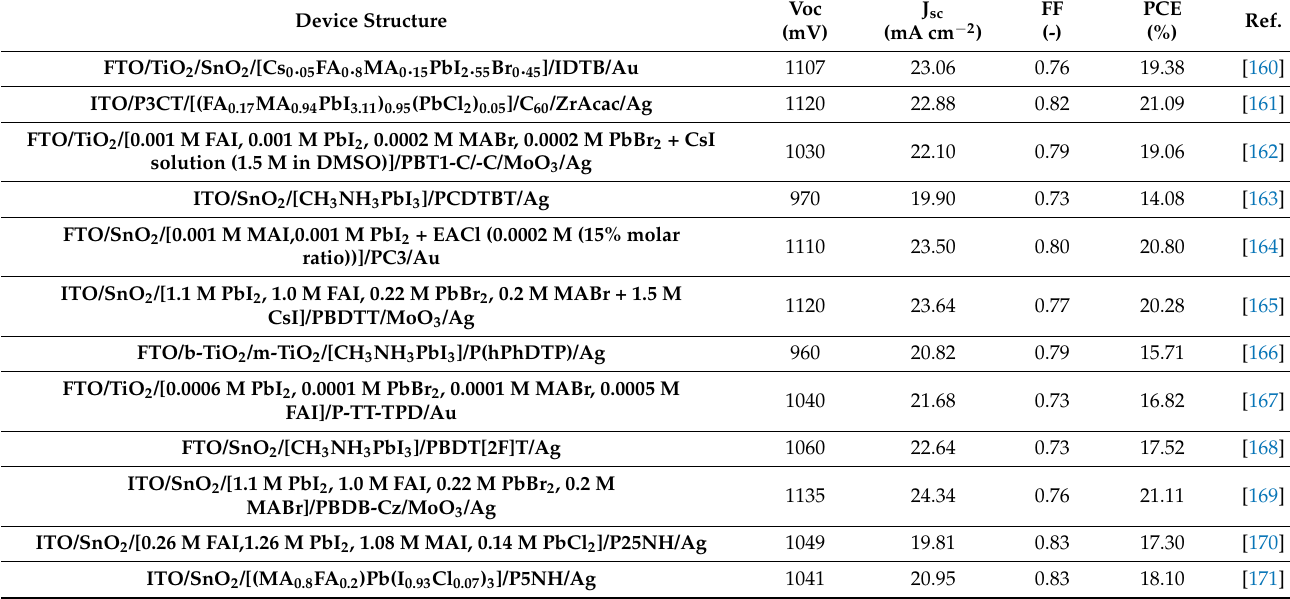
Table 9. The collected photovoltaic parameters of PSCs based on the analysed HTMs. Device Structure